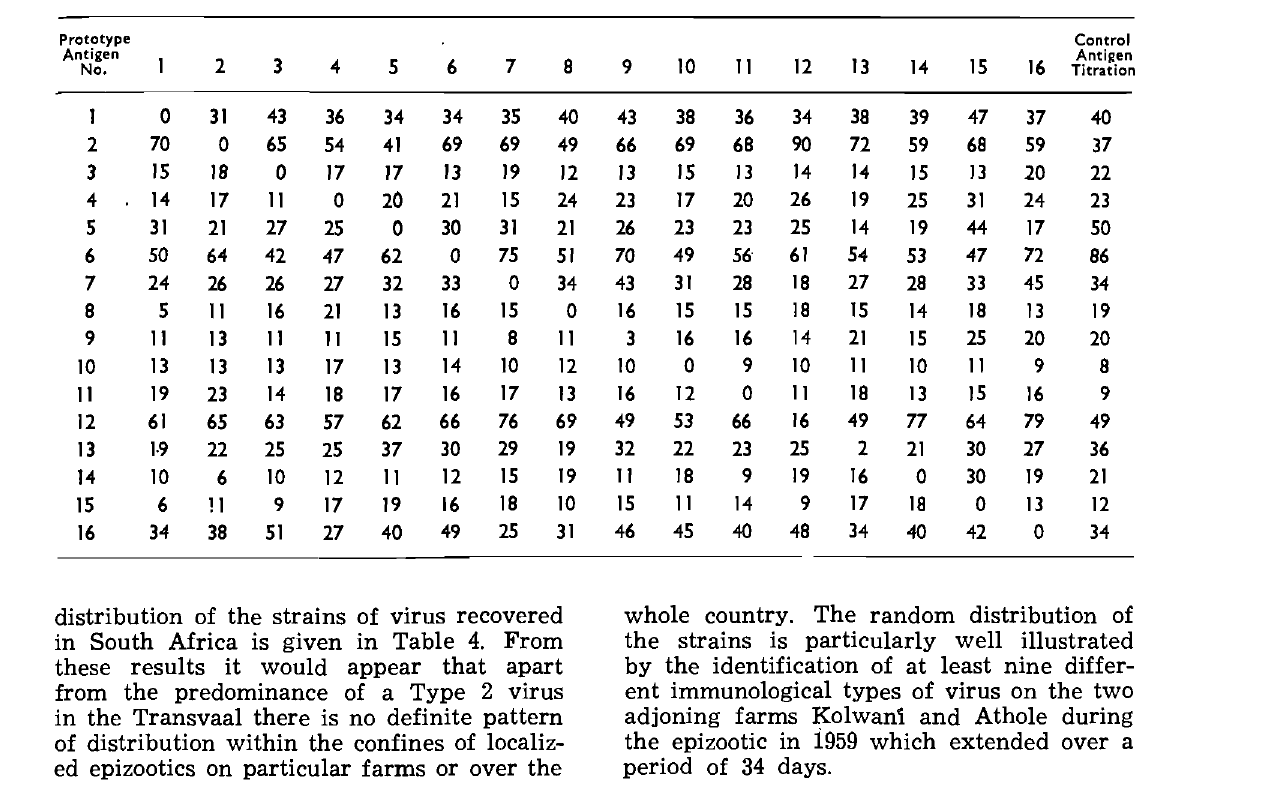
Table 4: SUMMARY OF THE ANTIGENIC CLASSIFICATION AND DISTRIBUTION OF STRAINS OF BLUE TONGUE VIRUS ISOLATED IN SOUTH AFRICA FROM 1959-1965 Province